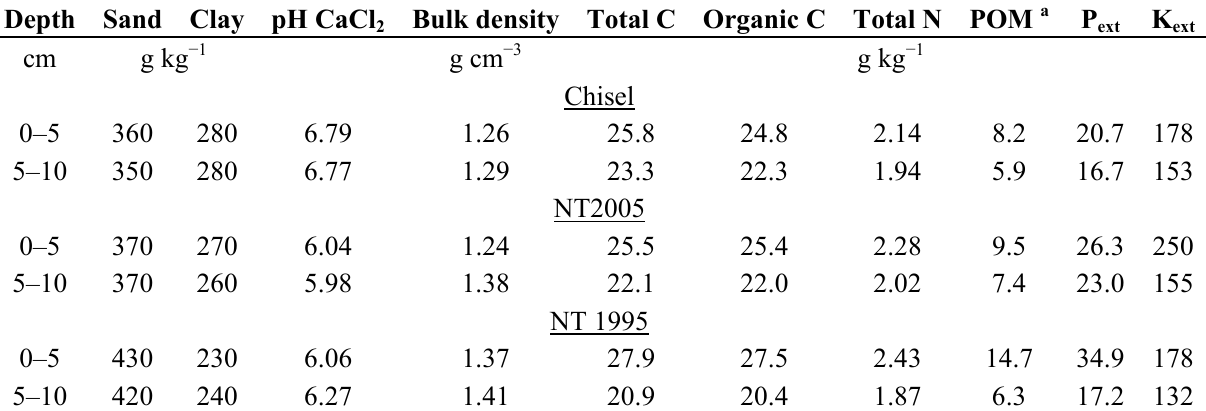
Table 3. Initial near-surface soil properties were determined on soil collected during fall 2005 from three fields differing in tillage